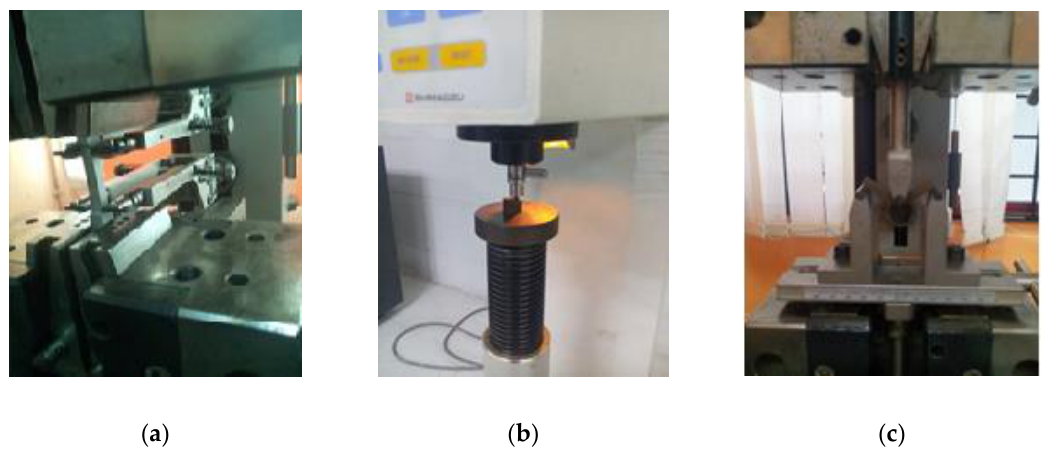
Figure 2 . Machines for mechanical test performed for: ( a ) tensile test; ( b ) hardness test; and ( c ) three-point bending test.